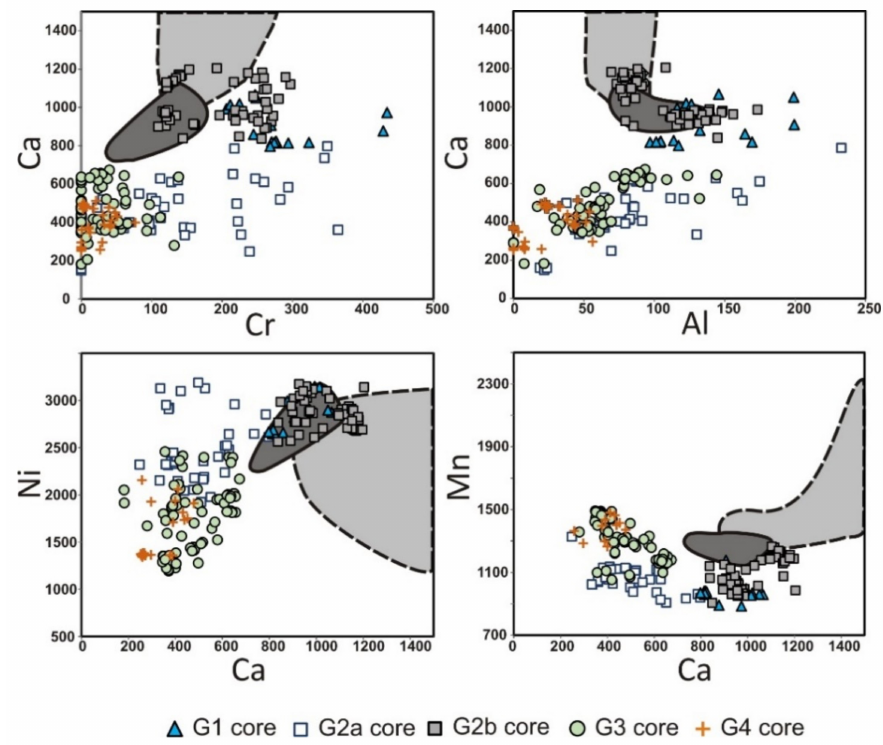
Figure 9. Compositional variation (ppm) of olivine macrocrysts from aillikites of the Terina complex. Legend as in Figure 4. Dark gray field—compositions of the central parts of groundmass olivines, light gray field—compositions of the rims of groundmass